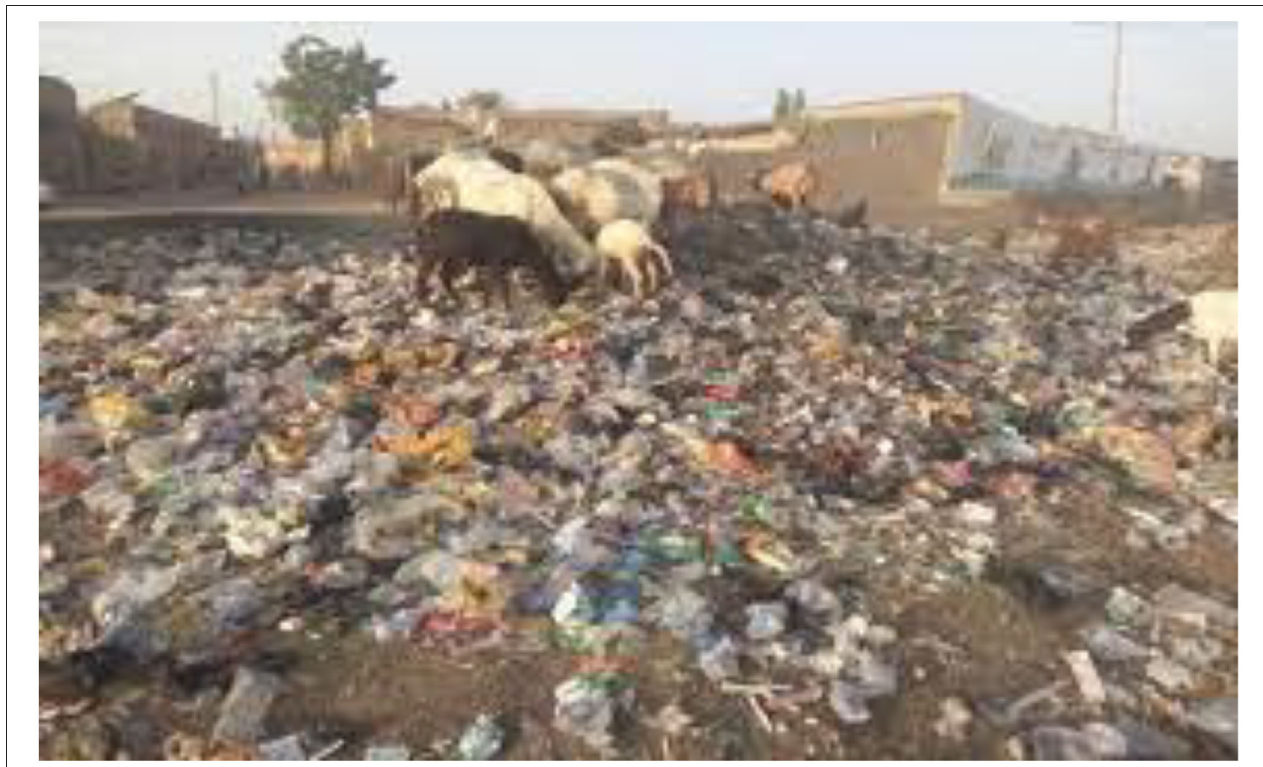
FIGURE 1 | Solid waste at uncontrolled open dumped site. Source: Hotoro, Tarauni Local Government Area, Kano State, Nigeria, 2020.